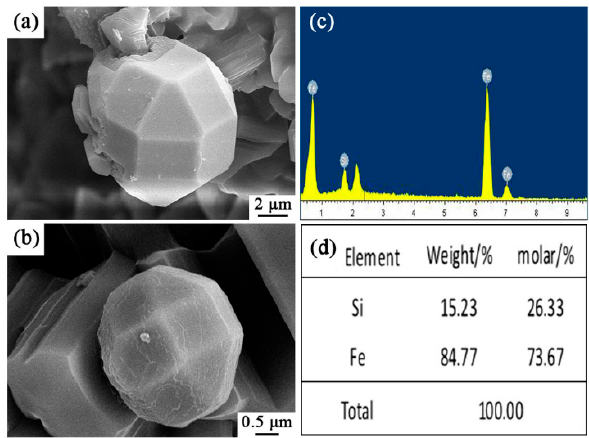
Figure 10. SEM images and EDS patterns of Si-Fe alloy of sample S5 nitrided at 1600 °C: ( a , b ) SEM images of spherical particles in sample S5, ( c , d ) EDS results of the selected area in ( a,b ).